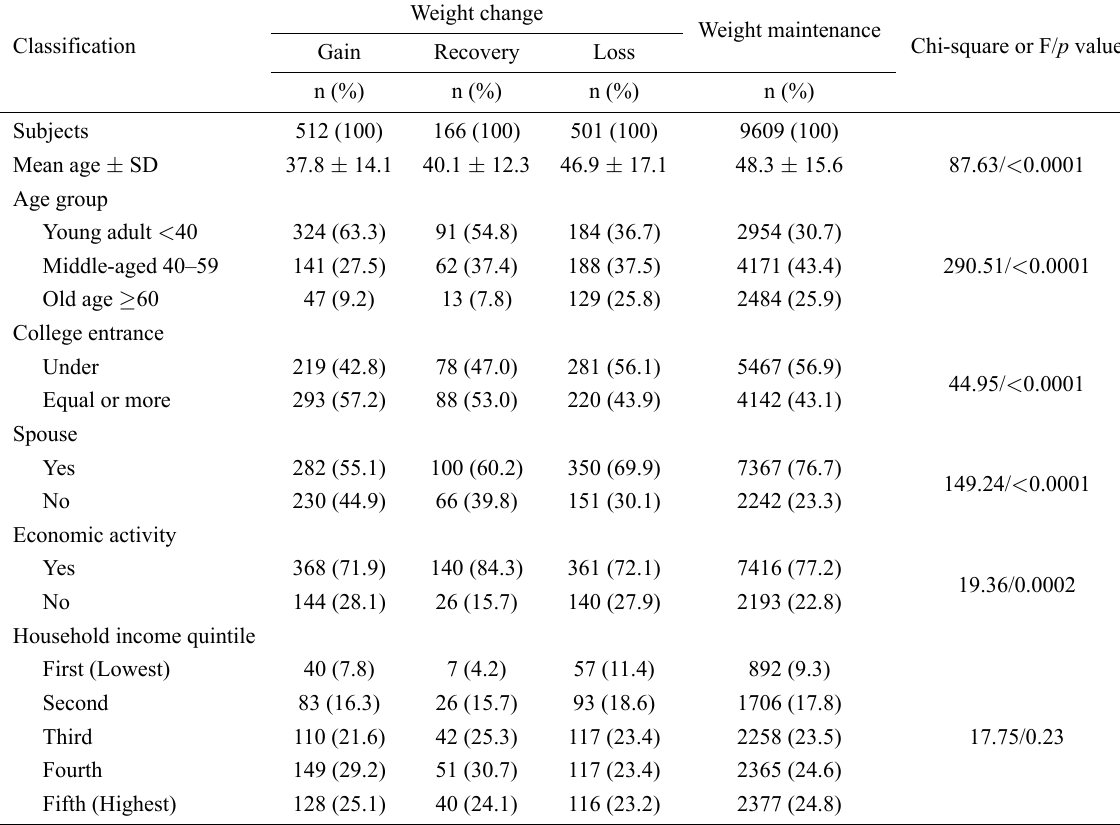
Table 2. Sociodemographic characteristics according to male subject’s weight change and